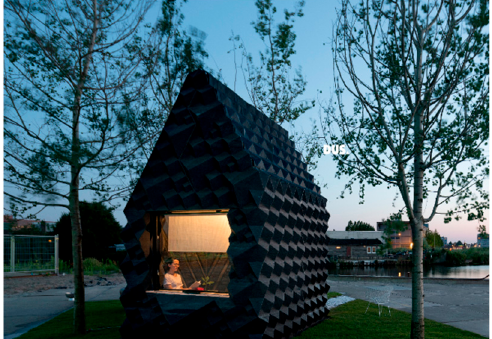
Figure 19. The first 3D ‐ printed house by DusArchitects [201]. Figure reproduced with permissions.